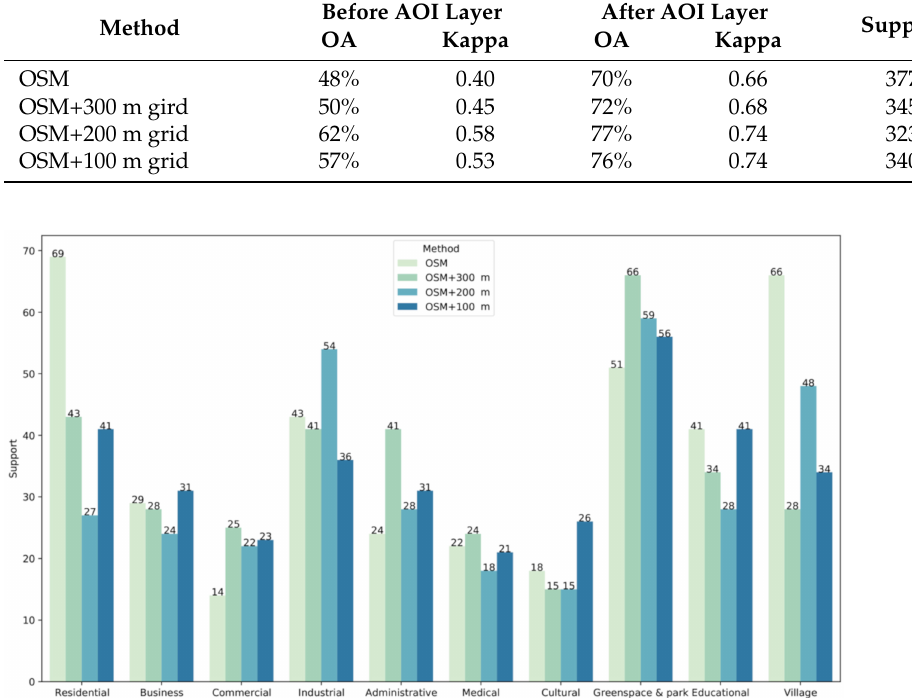
Figure 12. The number of validation units in each category of the four methods. Support donates the number of validation